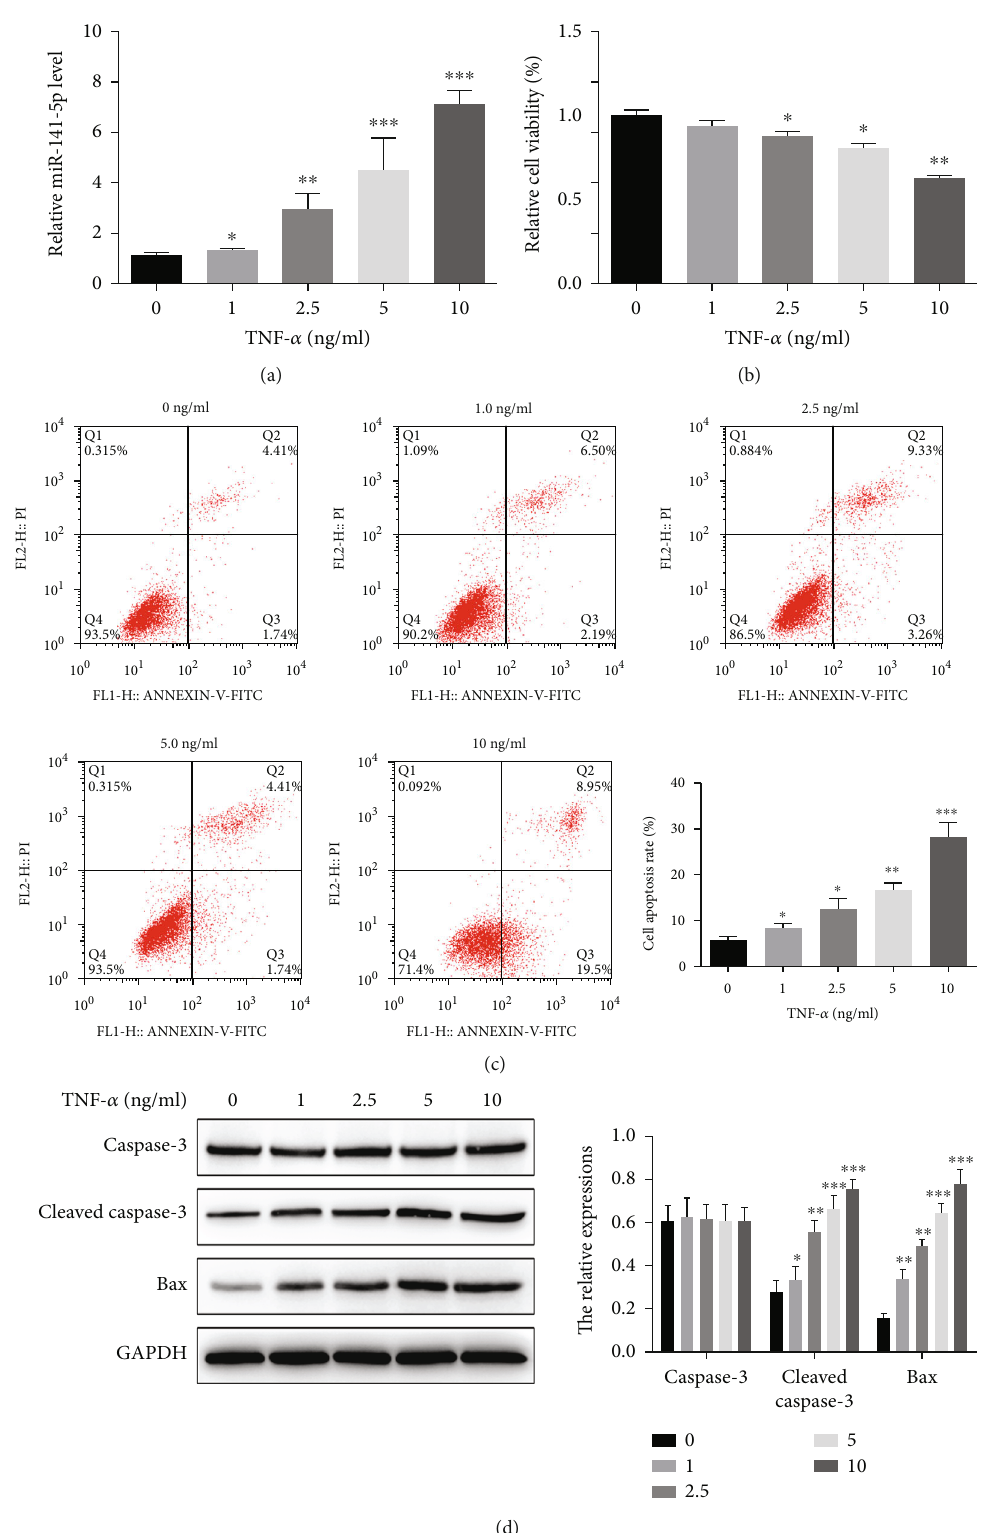
Figure 1: TNF- α increases miR-141-5p expression, suppresses the viability, and promotes the apoptosis of primary osteoblasts in a dose- dependent manner. (a) TNF- α dose-dependently increased miR-141-5p expression as detected by qRT-PCR. (b, c) TNF- α reduced cell viability and increased cell apoptosis in a dose-dependent manner as detected by CCK-8 assay and fl ow cytometry, respectively. (d) TNF- α increased the protein expression level of Bax and cleaved-Caspase-3 dose-dependently as detected by immunoblotting. ∗ P < 0 : 05 , ∗∗ P < 0 : 01 , and ∗∗∗ P < 0 : 001